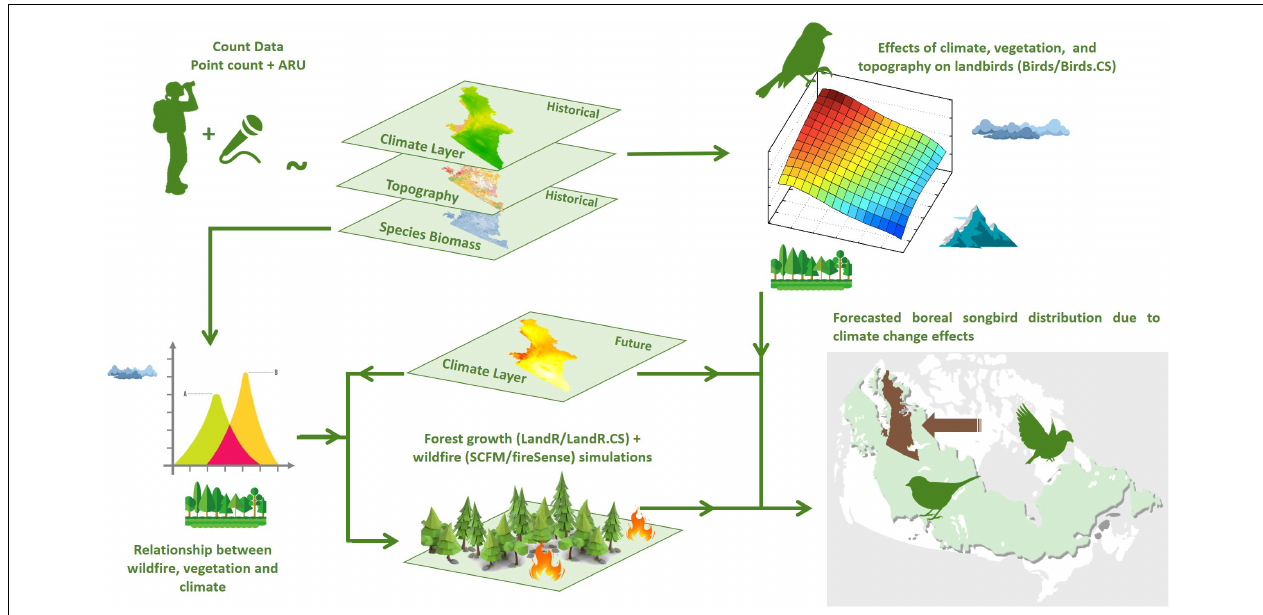
FIGURE 1 | Study framework connecting boreal landbird model (Birds/Birds.CS) fitting, forest growth (LandR/LandR.CS), and wildfire (SCFM/FireSense) simulation and landbird occupancy forecasting. Point-count data to generate landbird models was compiled from the database of the Boreal Avian Modelling Project (Barker et al., 2015), supplemented with data from Automated Recording Units (ARUs; WildTrax, 2019).